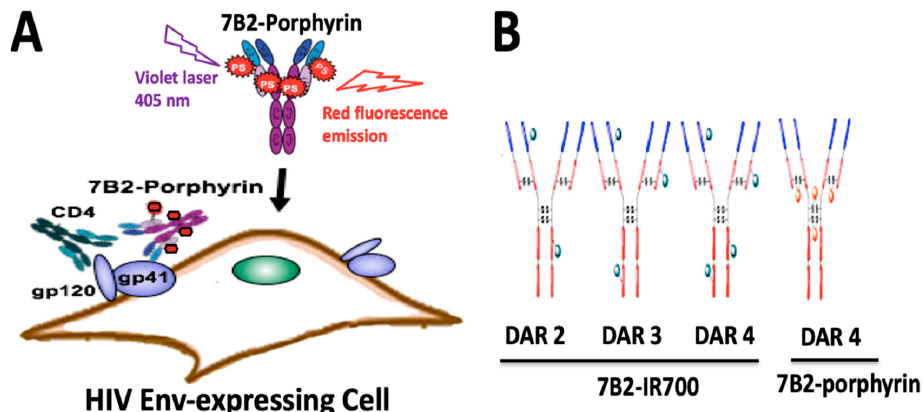
Figure 1. Structure and function of photo-immunoconjugates (PICs). ( A ) Anti-gp41 monoclonal antibody (7B2 MAb) conjugated with 4 porphyrins can specifically bind to the HIV infected cells expressing HIV Env (gp41 and gp120). The presence of CD4 may increase the binding ability of 7B2-porphyrin to the gp41 on the cell membrane. Porphyrins can be activated by visible light of a specific wavelength (herein 405 nm) to initially generate singlet oxygen or ROS reaction, and consequently kill the target cell. Furthermore, the emission of red fluorescent by porphyrin can be observed during irradiation. ( B ) Schematic picture demonstrates two generations of PICs in the study; Lysine